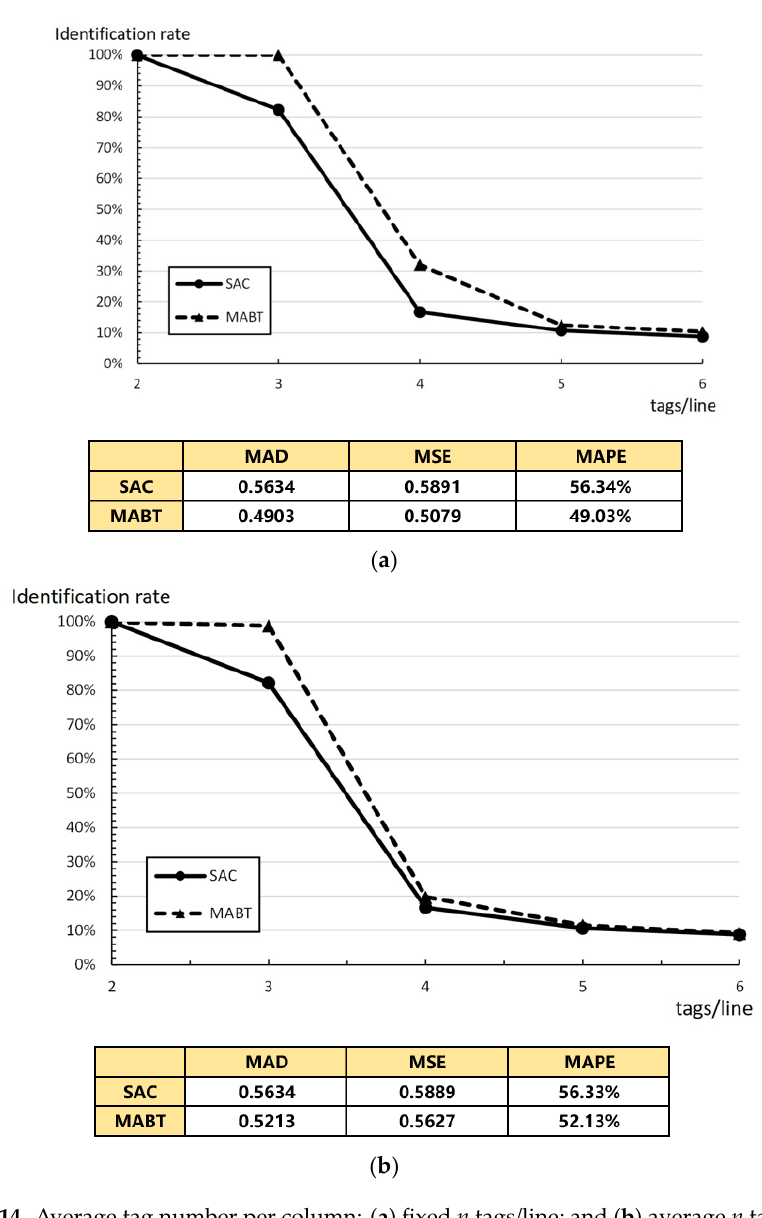
Figure 14. Average tag number per column: ( a ) fixed n tags/line; and ( b ) average n tags/line.